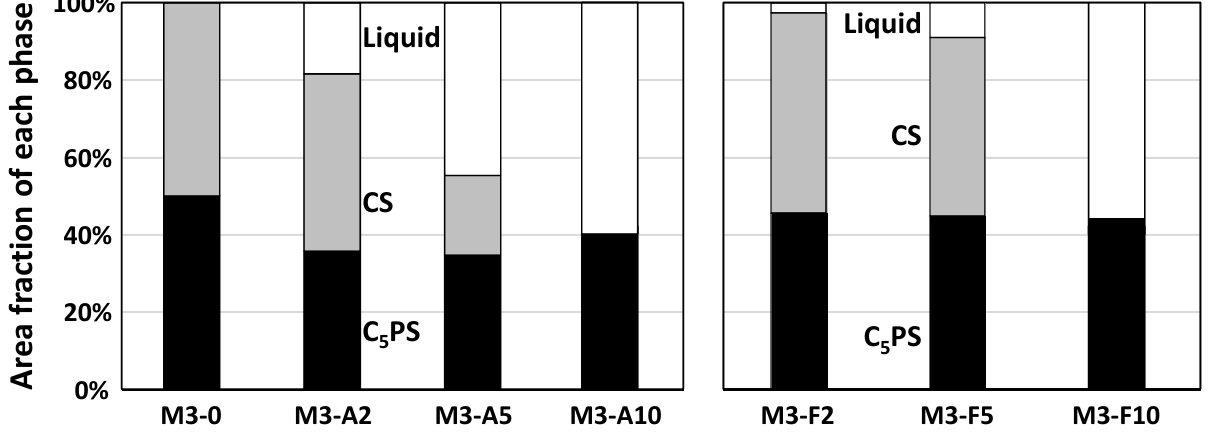
Figure 16. Area fraction of each phase that appeared in the SEM analysis.